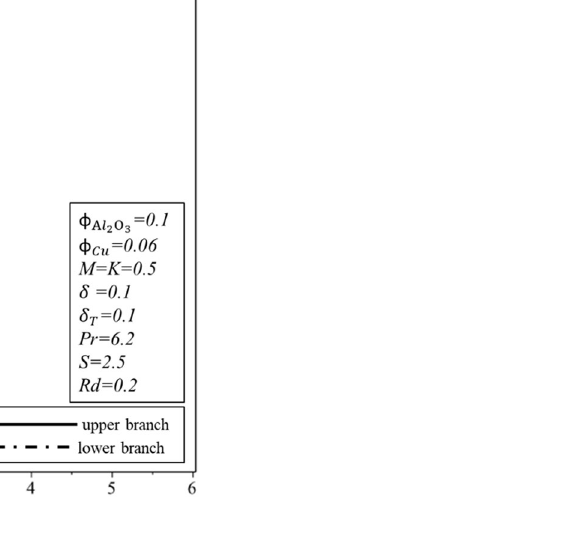
Figure 12. Behavior of f ′ (η) in impact of (cid:31) 1